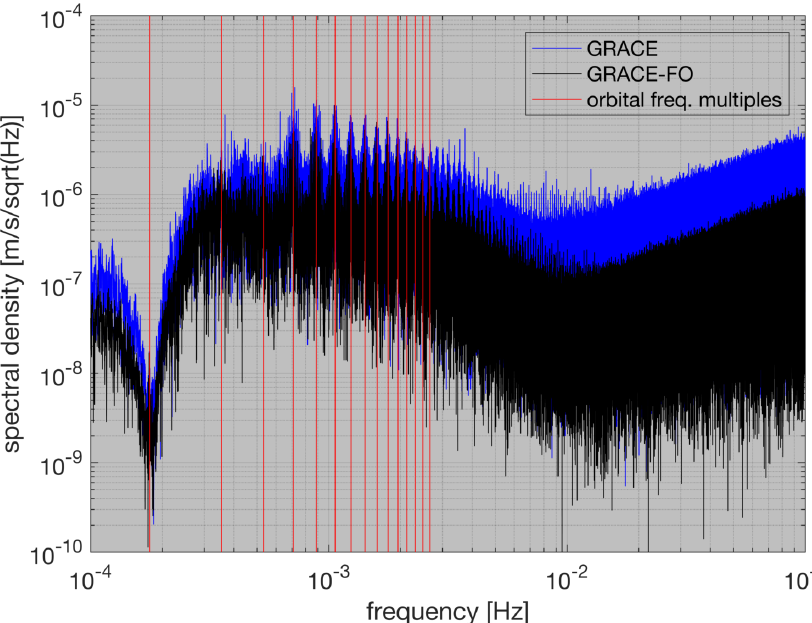
Figure 5. Power spectral density of the KBRR post-fit residuals in the frequency band from 10 − 4 to 10 − 1 Hz. First 15 multiples of the orbital frequency are